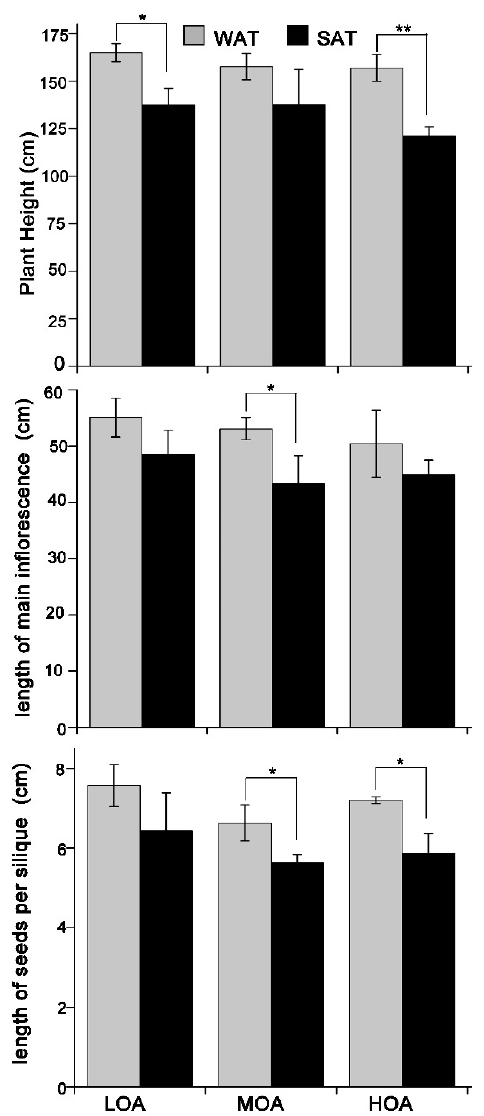
Figure 3. Genotype means for plant height, length of main inflorescence, and length of seeds per silique in the third year. Values are means ± SD (n = 3 plots). * p < 0.05, ** p <